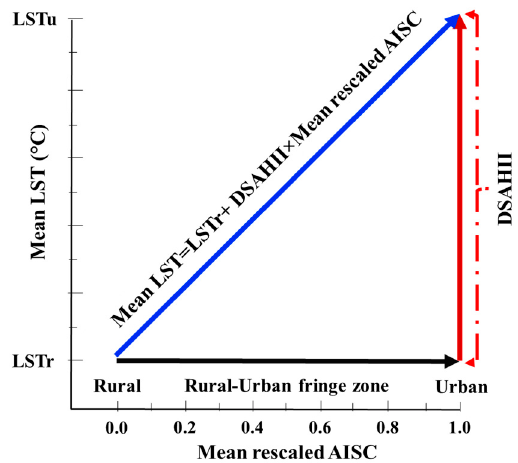
Figure 3. Conceptual diagram of modelling the daytime surface anthropogenic heat island intensity (DSAHII) based on the land surface temperature (LST)-actual impervious surface cover (AISC) feature space. The LSTu is the urban LST, representing the LST in the urban area where the rescaled AISC is 1 (AISC is 100%), and LSTr is the rural LST, representing the LST in the rural area where the rescaled AISC is 0 (AISC is 0%).